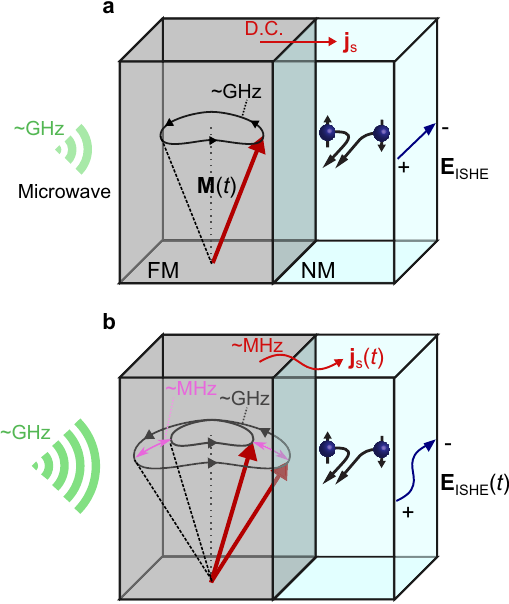
Figure 1. Concept of generation of MHz-band spin currents by nonlinear spin pumping. ( a,b ) Spin pumping at the interface between ferromagnetic material (FM) and nonmagnetic metal (NM) in a linear regime ( a ) and an auto-oscillation (AO) regime ( b ) of magnetization dynamics. When the power of an incident microwave is below the threshold value of AO ( a ), the precessing magnetization, M ( t ), injects a d.c. spin current, j s , into the NM via the spin pumping effect, which results in the d.c. electromotive force E ISHE via the inverse spin Hall effect (ISHE). When the microwave power exceeds the threshold value of AO ( b ), the solid angle subtended by M ( t ) exhibits AO. As a result, a MHz-band spin current, j s ( t ), arises from spin pumping, which is finally converted into pulsating electromotive force, E ISHE ( t ) via